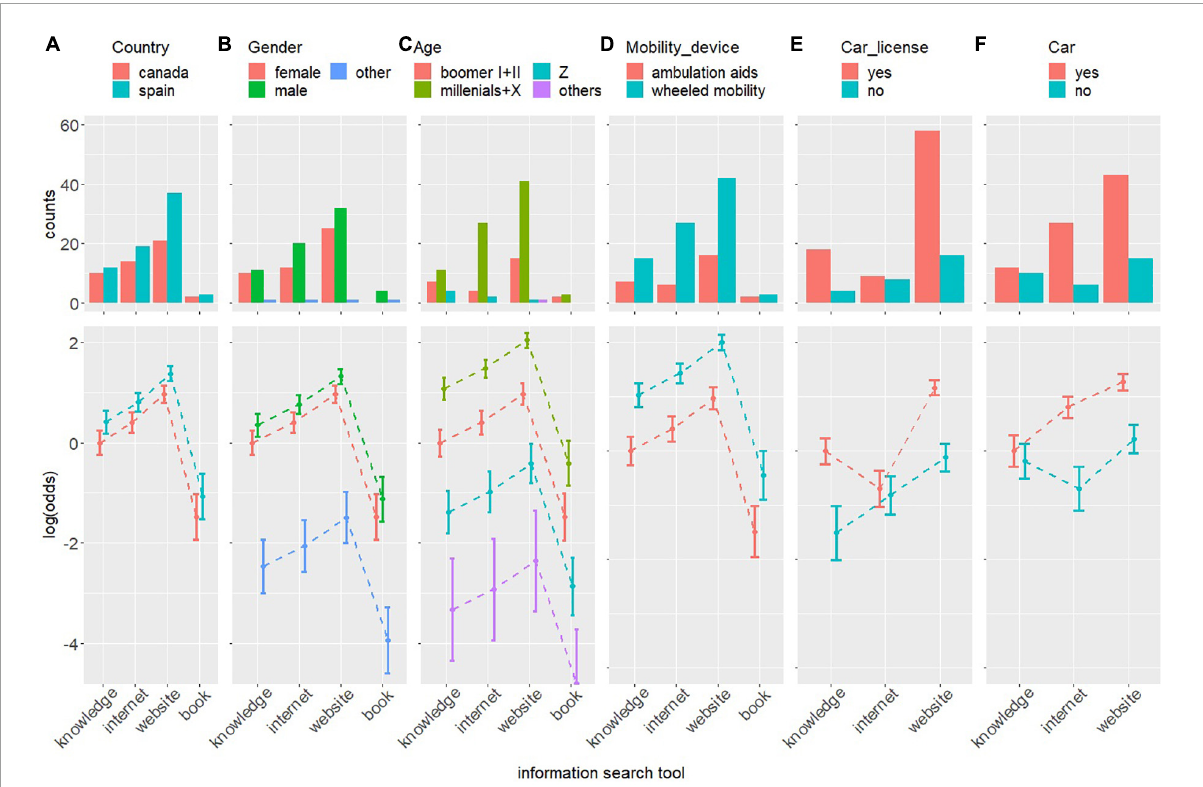
FIGURE1 Histograms and the logarithm of the odds resulting from applying a log-linear model in the cross-frequency tables of the relationships between the demographic and individual characteristics of, from left to the right, country (A) , gender (B) , age (C) , mobility assistive device (D) , driver’s license (E) , and own car (F) of PwMDs and PwMDs’ use of different information search tools to prepare the